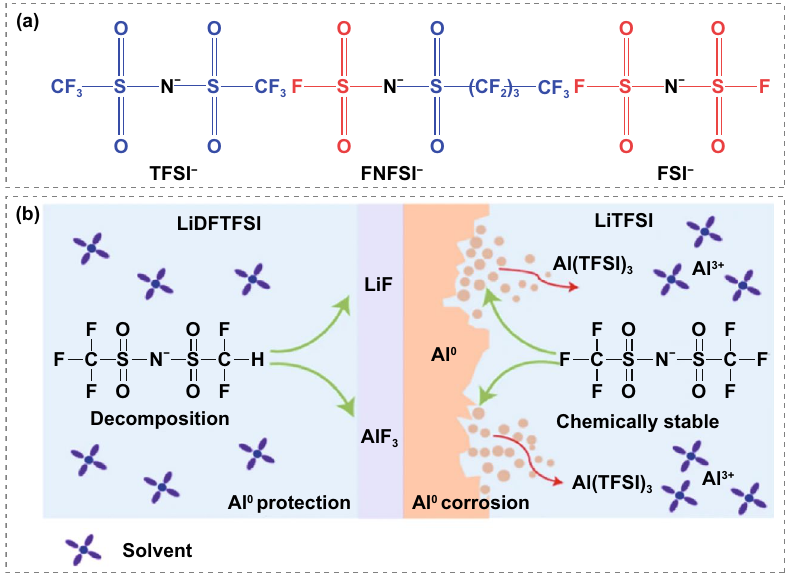
Fig. 8 New lithium salt design: a Structures of TFSI – , FNFSI – , and FSI – anions. Copyright from Ref. [140]. b Structures of DFTFSI– and TFSI– anions and schematic illustration of the possible Al corrosion. Copyright from Ref.